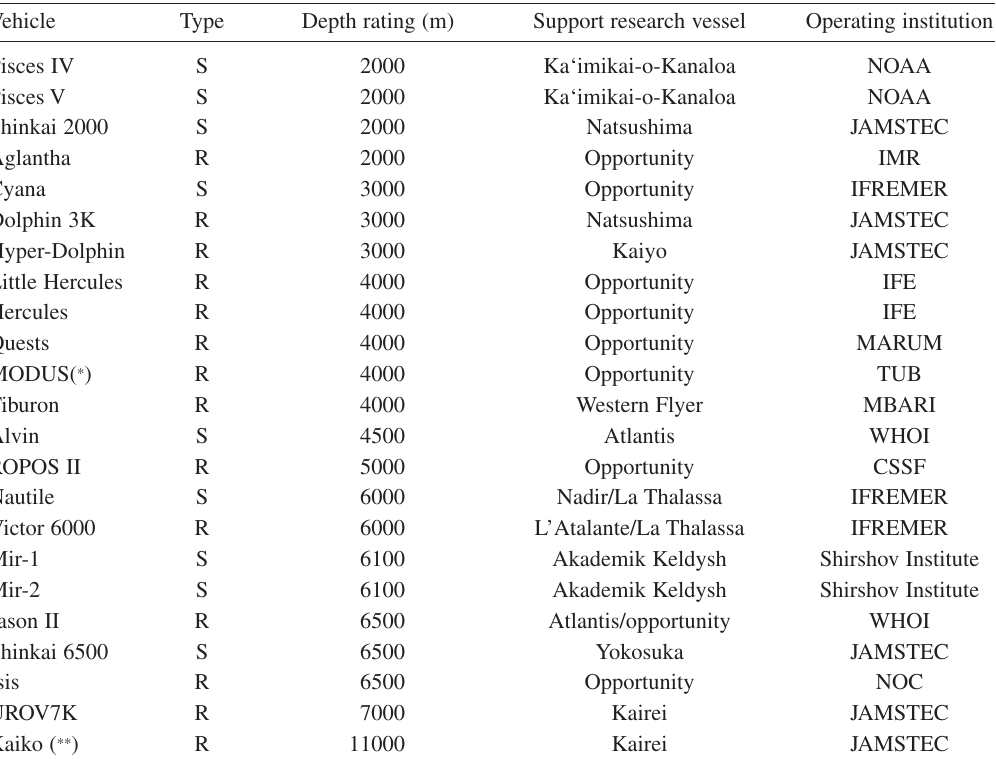
Kaiko ( ** ) R ( * ) Primarily designed for GEOSTAR; ( ** )lost in